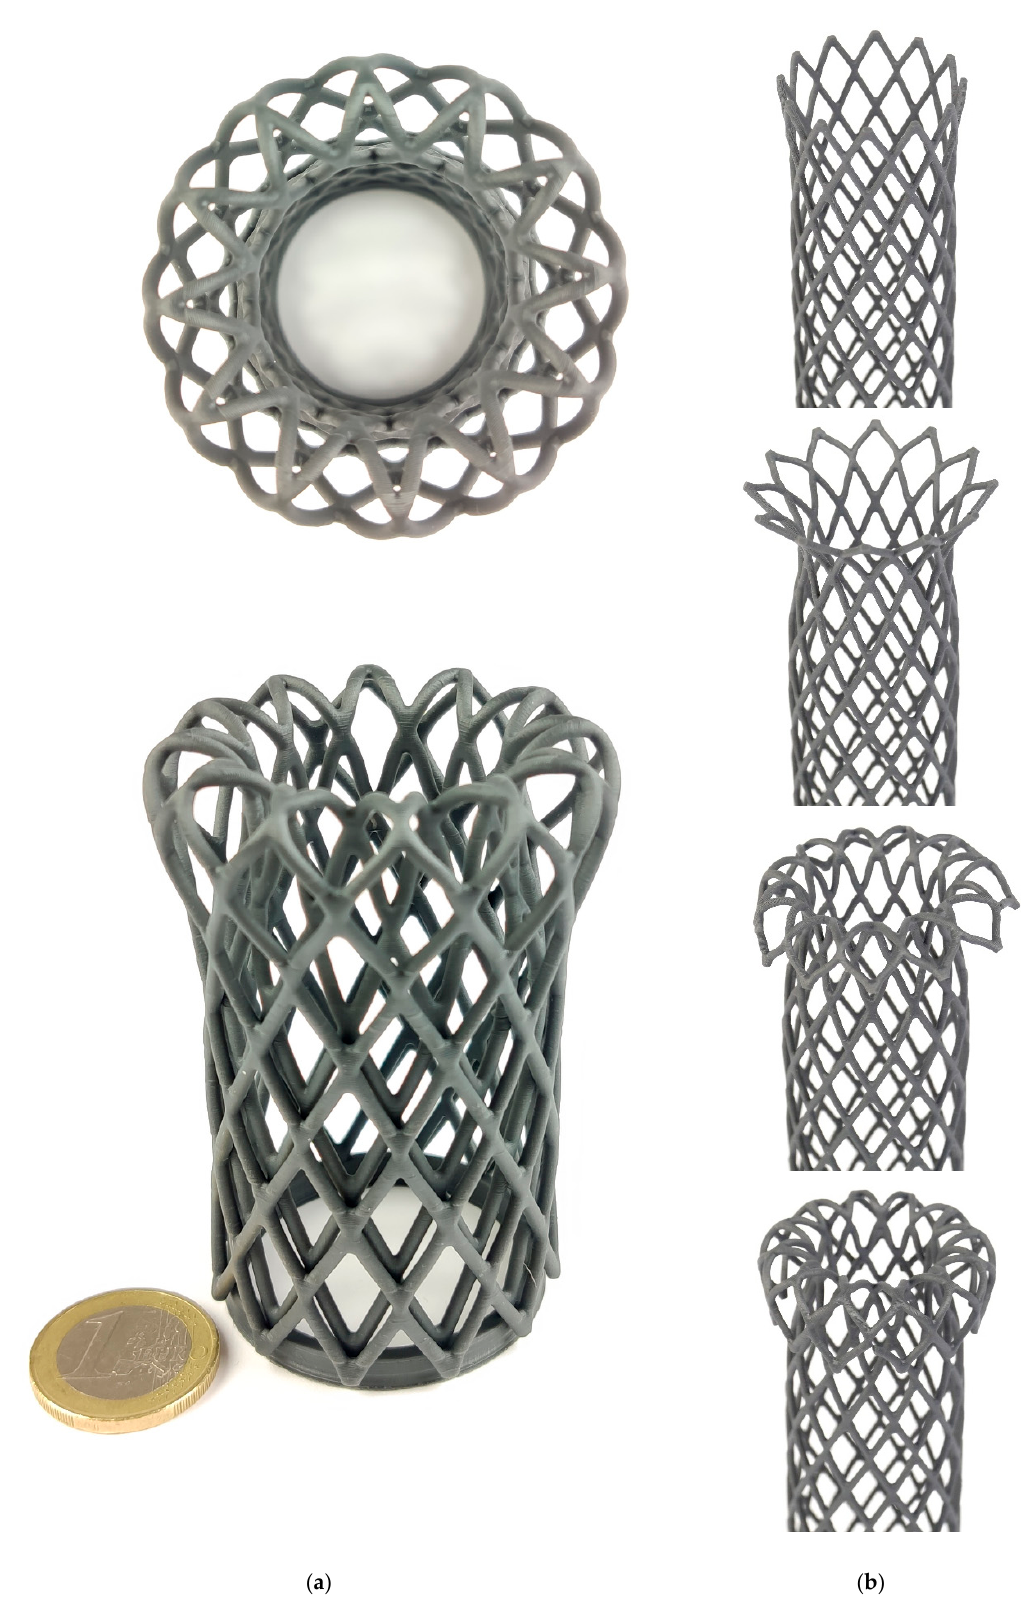
Figure 17. Additively manufactured everted tubular net structure with homogenized nodes: everted over the entire length in top and side view ( a ) and in different stages of the everting process from top to bottom ( b ) (captured in reverse transformation).